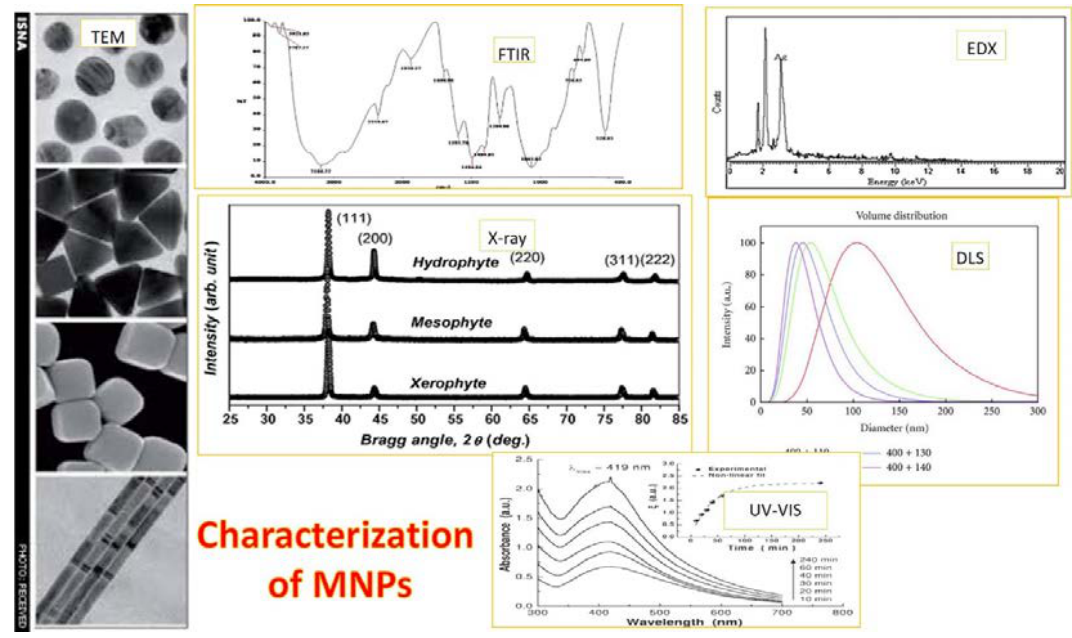
Fig. 3: Techniques for characterization of metallic